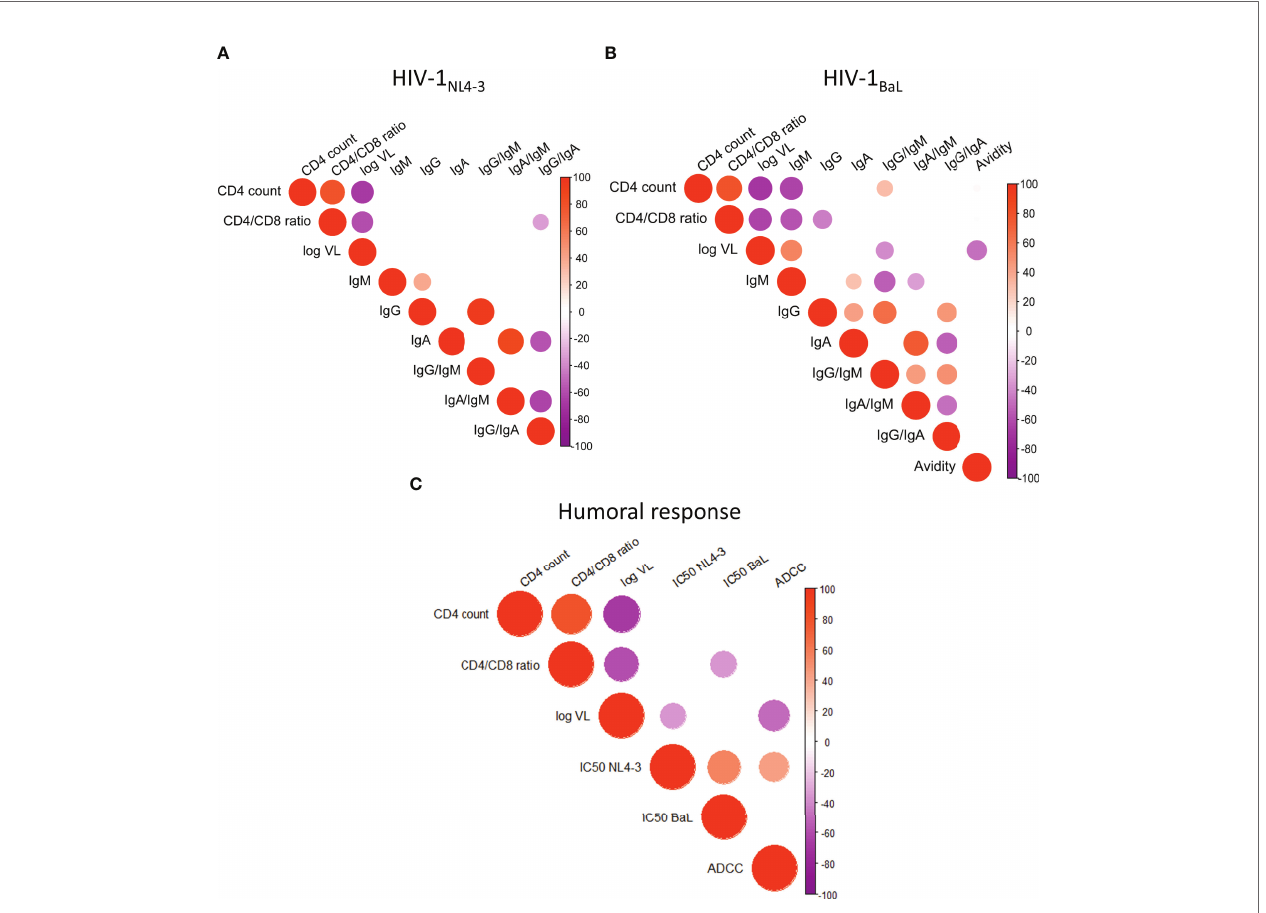
FIGURE 7 | Humoral anti-HIV functional responses link with clinical parameter's. (A) Correlation between anti-HIV-1NL4_3 antibody titers and CD4 count, CD4/CD8 ratio and plasma viral load. (B) Correlation between anti-HIV-lBaL antibody titers and CD4 count, CD4/CD8 ratio and plasma viral load. (C) Correlation between humoral functional response (HIV-1NL4_3 and HIV-lBad neutralization activity, ADCC and CD4 count, with CD4/CD8 ratio and plasma viral load. Correlations were performed by non-parametric Spearman r test. Positive correlations are indicated in red while negative correlations in purple, color intensity in proportional to Spearman's rho and circle size is related to the p-value when signi fi